Question: What form of chart is displayed?
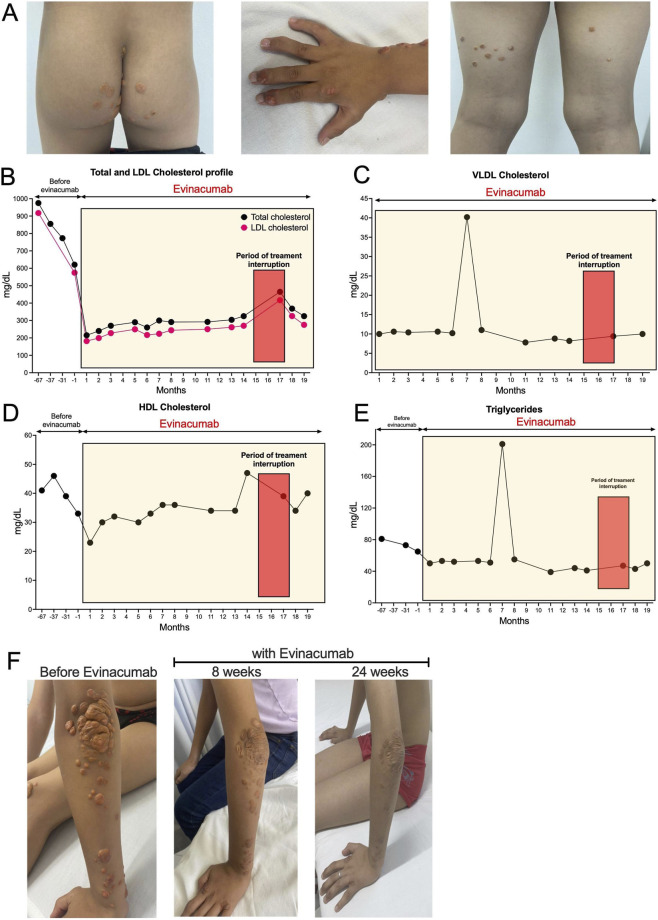
Answer: line